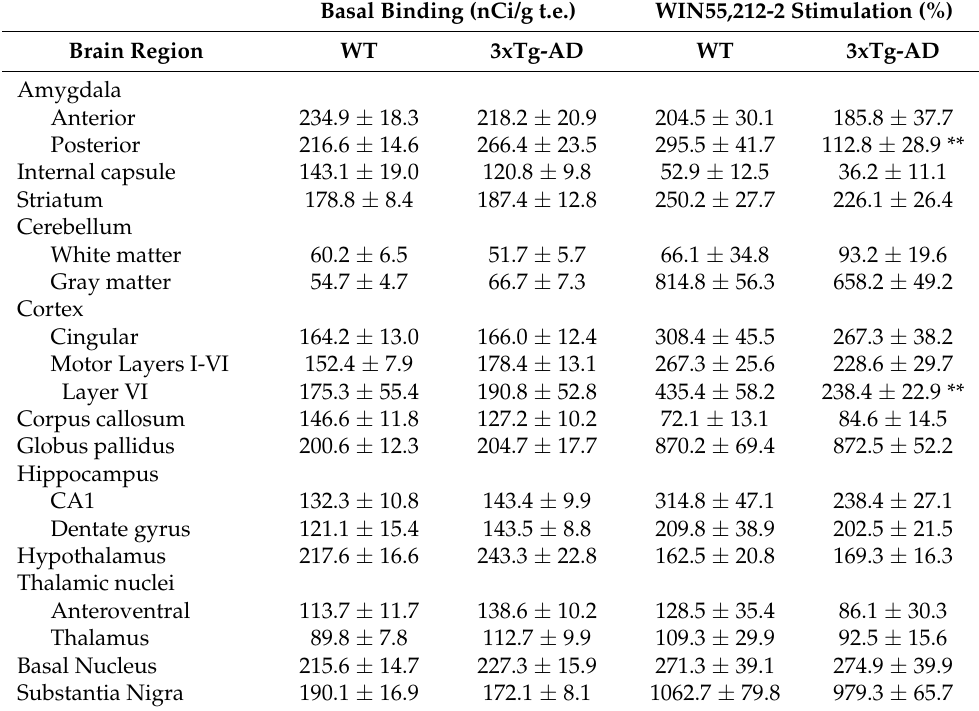
Table 1. [ 35 S]GTP γ S basal binding in different areas of WT and 3xTg-AD mice brain (nCi/g t.e) and induced by WIN55,212-2 (10 µ M) expressed in percentage of stimulation over the basal. n (WT) = 12; n (3xTg-AD) = 16. Data are mean ± SEM